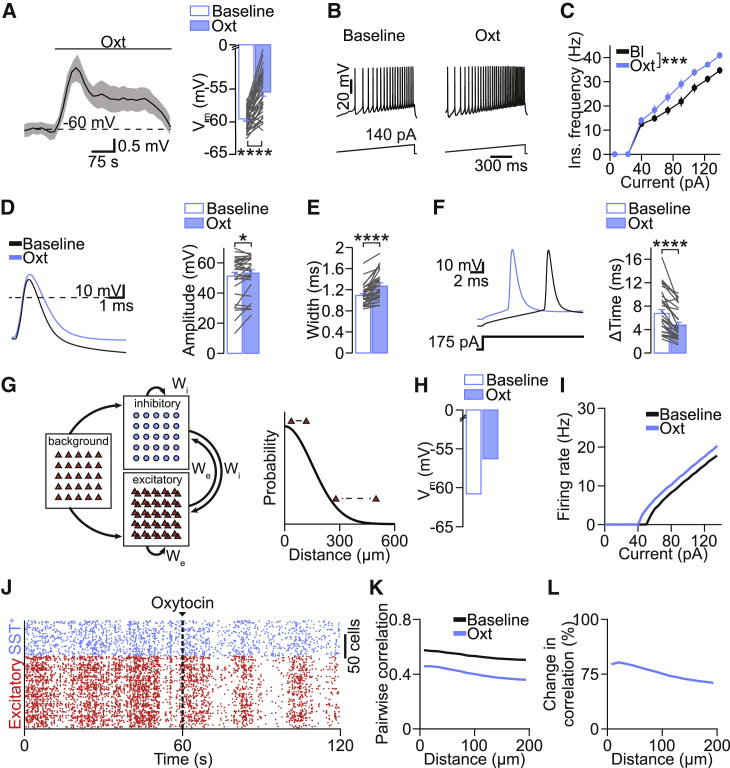
Oxytocin-Induced Increase of the Excitability of SST+ Interneurons Is Sufficient to Explain Distance-Dependent Changes in Correlation(A) Average of current-clamp recordings of SST+ neurons before and after oxytocin bath application. Right: group data of SST+ interneuron membrane potential in baseline and oxytocin conditions are shown. ∗∗∗∗p = 4.7 × 10−10 (n = 34 cells; paired two-tailed t test).(B) Train of APs generated with a ramp protocol in current-clamp mode in baseline and oxytocin conditions.(C) Instantaneous frequency versus current plot. ∗∗∗p < 0.0001 (n = 34 cells; repeated-measurements two-way ANOVA).(D) Left: single APs aligned to the peak in baseline and oxytocin conditions. Right: group data of AP amplitude in baseline and oxytocin conditions are shown. ∗p = 0.038 (n = 34 cells; paired two-tailed t test).(E) AP width. ∗∗∗∗p = 1.8 × 10−6 (paired two-tailed t test).(F) AP. Left: single APs in response to a square current step in baseline and oxytocin conditions. The time required to elicit an action potential was strongly reduced in the presence of oxytocin. ∗∗∗∗p = 8.9 × 10−7 (paired two-tailed t test). Data are represented as mean ± SEM.(G) Left: schematic of the model with excitatory background input and recurrently connected excitatory (red) and inhibitory populations (blue). We, excitatory weight; Wi, inhibitory weight. Right: connection probability as a function of distance between cells is shown.(H) Resting membrane potential of SST+ interneurons during baseline and oxytocin.(I) Firing rate of inhibitory cells as a function of the input current in baseline and oxytocin.(J) Spike raster plot of excitatory (red) and SST+ interneurons (blue) neuron populations before and after application of oxytocin (see STAR Methods).(K) Correlation as a function of distance for baseline and oxytocin conditions. See STAR Methods for calculation details.(L) Change in correlation as a function of distance.See also Figure S5 and Table S1.